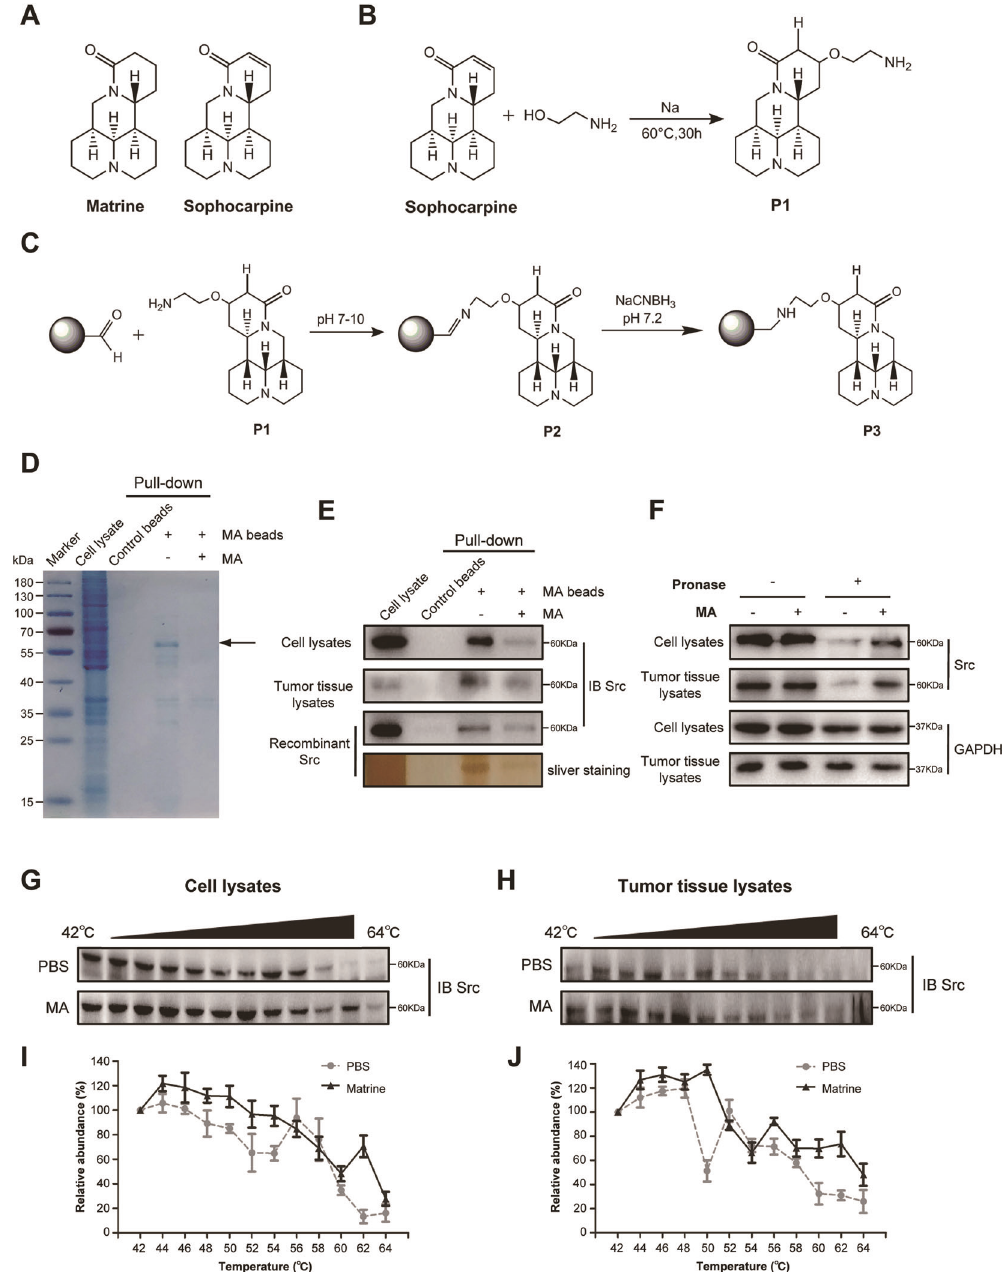
Fig. 2 Matrine targeted Src protein. A Chemical structure of matrine and sophocarpine. B The synthesis scheme of 13 α -(2-amino) ethoxymatrine (P1). C Synthesis of matrine-amino coupling resins (MA beads, P3). D SKOV3 cell lysates were incubated with control beads, MA beads, and MA beads in the presence of matrine (2.0 mg/mL). Protein af fi nity pull-down assay was performed and the matrine-bound proteins were separated by SDS-PAGE. The gels were processed by Coomassie brilliant blue staining. E Pull-down assays were performed using cell lysates, tumor tissue lysates, and recombinant protein GST-Src. The cell lysates, tumor tissue lysates, and recombinant proteins were incubated with control beads, MA beads, or MA beads in the presence of matrine (2.0 mg/mL). The mixtures were blotted for Src and sliver staining. F DARTS results for pronase-digested cell lysates and tumor tissues. Cell lysates and tumor tissue lysates were prepared with matrine or PBS for 1 h, followed by digestion with pronase. Western blotting showed protection of the target protein Src, whereas digestion of the non-target proteins GAPDH is unchanged by matrine. G , H CETSA was performed in cell lysates ( G ) and tumor tissue lysates ( F ) treated with matrine or PBS. The stabilization of matrine on Src protein was evaluated by immunoblot. I , J CETSA curves in cell lysates ( I ) and tumor tissue lysates ( J ) treated with matrine or PBS. Data are presented as mean ± SD, n = 3 independent